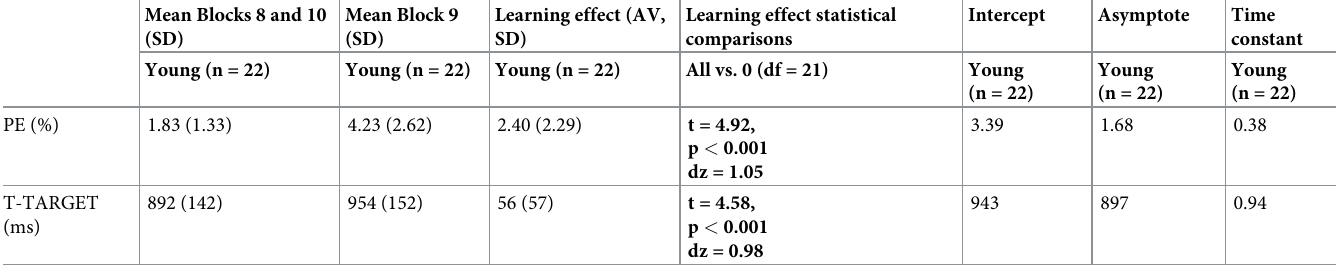
Table 1. Descriptive statistics, sequence-specific learning effects and performance curve parameters for the participants in Experiment 1.